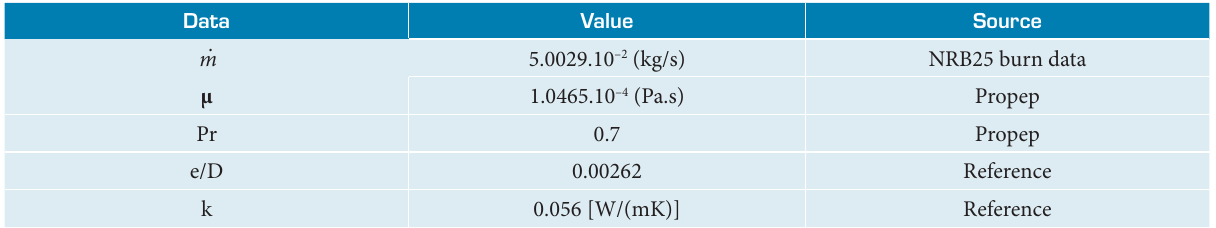
Table 7. Data for convection heat flux coefficient calculation.